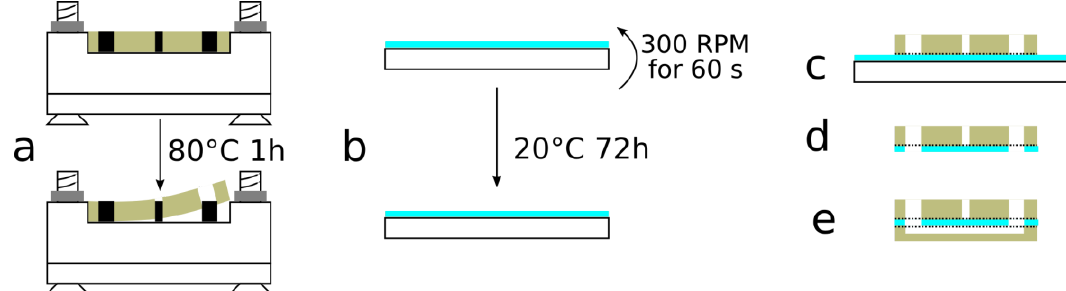
Figure 2. Fabrication and assembly of the spheroid culture chamber array (SCCA): ( a ) The 3D printed molds of the thick and channel layers were screwed onto polymethylmetacrylate (PMMA) plates, polydimethylsiloxane (PDMS) at 10:1 was poured inside the molds, cured at 80 °C for 1 h and removed from the molds; ( b ) For the membrane layer, PDMS at 20:1 was poured over a silanized glass wafer before being rotated at 300 rpm for 1 min and cured at room temperature for 72 h; ( c ) The thick layer and the membrane layer (still mounted on its substrate) were plasma bonded together; ( d ) Holes corresponding to the inlets/outlets were punched into the membrane layer using the thick layer as a guide; ( e ) The other side of the membrane layer and the channel layer were plasma bonded together.